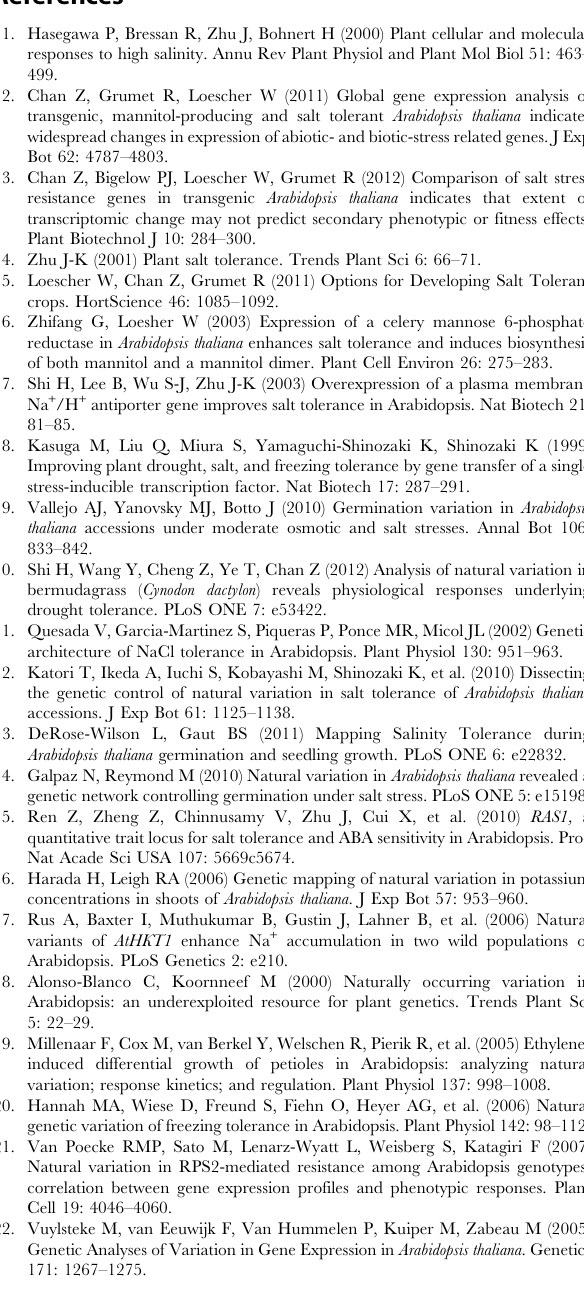
Figure S4 Cluster analyses of all differentially expressed genes by salt treatment or among ecotypes. Figure S5 Cluster analyses of specific pathway related genes. Table S1 Total gene lists differentially expressed by salt treatment or among ecotypes. Table S2 Transposable element, miroRNA and histone related transcripts differentially expressed by salt treatment or among